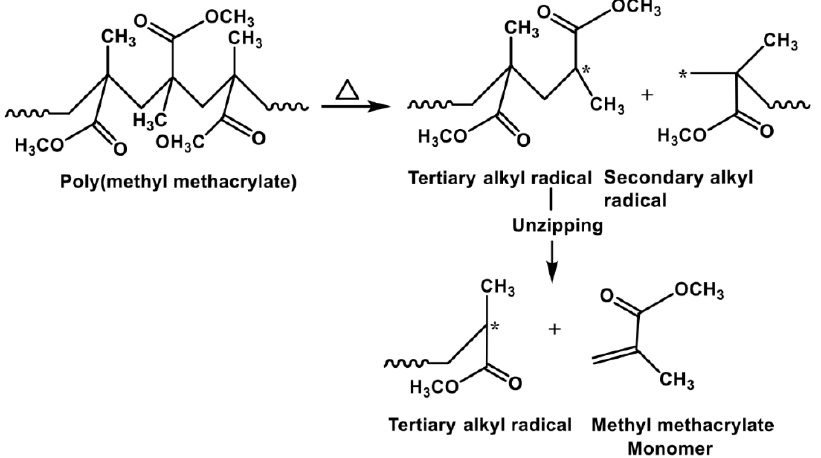
Scheme 1. Probable mechanism of the depolymerization of PMMA.